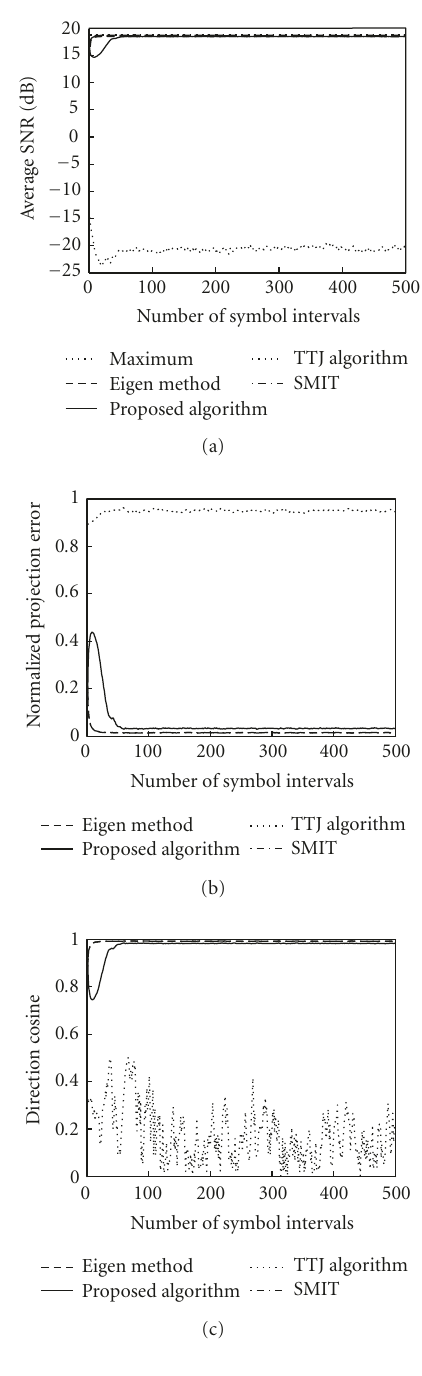
Figure 2: (a) SINR performance in the case of five interferers. (b) Normalized projection error in the case of five interferers. (c) Di- rection cosine performance in the case of five